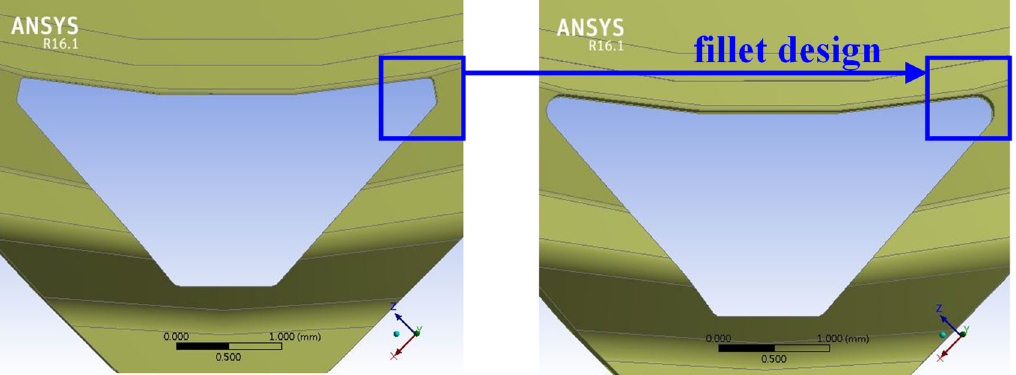
Figure 10. Illustration of the shoulder width.